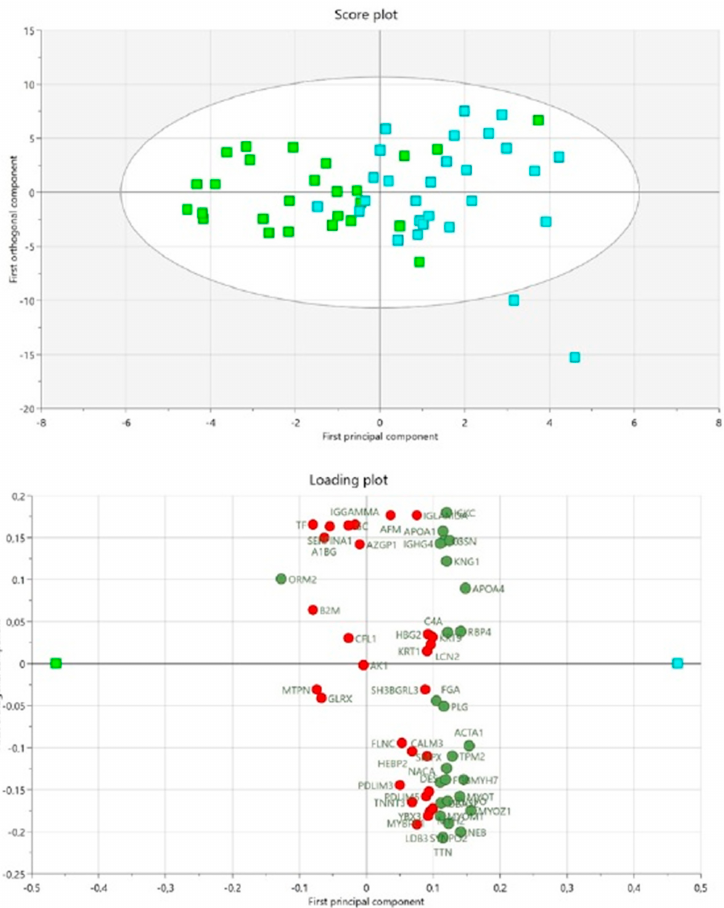
Figure 2. Differences in protein expression between patients with fibromyalgia and healthy controls at baseline using OPLS-DA. The score plot shows each observation and the separation between the fibromyalgia (FM) and healthy control (CON) groups. Green squares = FM group, turquoise squares = CON group. The loading plot shows significant proteins with a VIPpred > 1.0 (green circles) and non-significant proteins VIPpred < 1.0 (red circles). Green square = FM group, turquoise square = CON group. Significant proteins, including abbreviations, are shown in Table